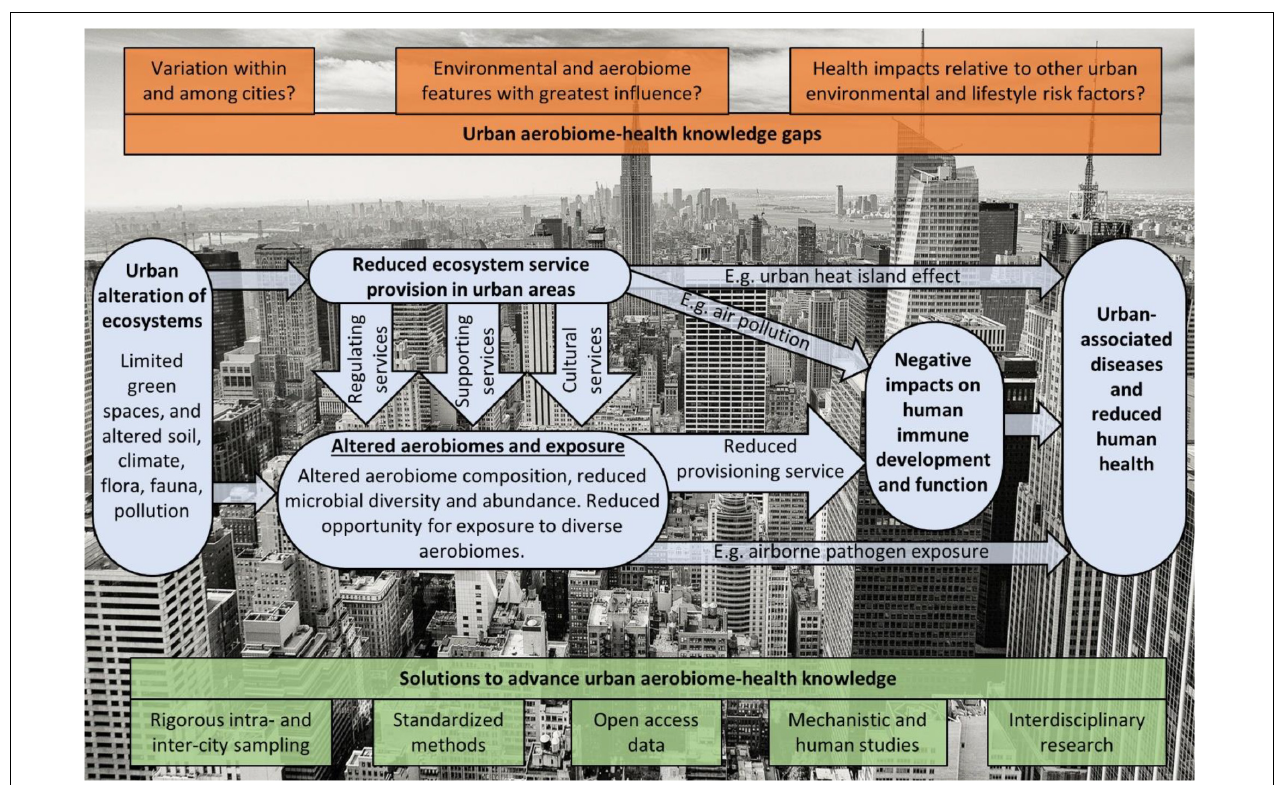
FIGURE 1 | A conceptual diagram of how urbanization alters ecosystem services, aerobiomes and human health. Urban areas generally have less vegetation (green spaces) and altered ecosystems that result in reductions to many ecosystem services with direct and indirect impacts on health. Both reductions in regulating services (e.g., resulting in reduced air quality/greater air pollution) and supporting services (e.g., resulting in reduced maintenance of genetic diversity) impact the composition, and microbial diversity and abundance of aerobiomes. Additionally, less biodiverse and/or less extensive green spaces in cities limits outdoor recreation opportunities (a cultural ecosystem service). This reduced exposure to biodiverse aerobiomes for urban-dwelling people stifles the provisioning service that biodiverse microbiome exposure has on healthy immune development and function, leading to poor health outcomes. We highlight knowledge gaps in red and potential solutions to advance this field in